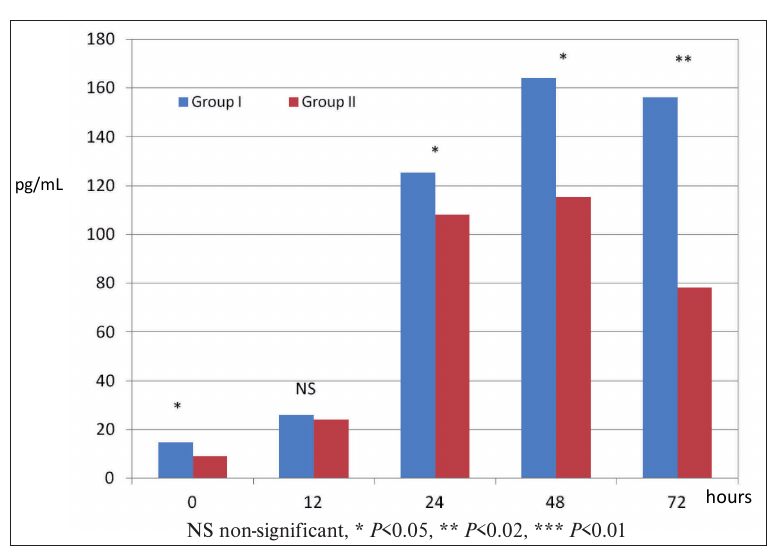
Fig. 4. Serum IL-6 before and after surgery in Group I and Group II (mean values).